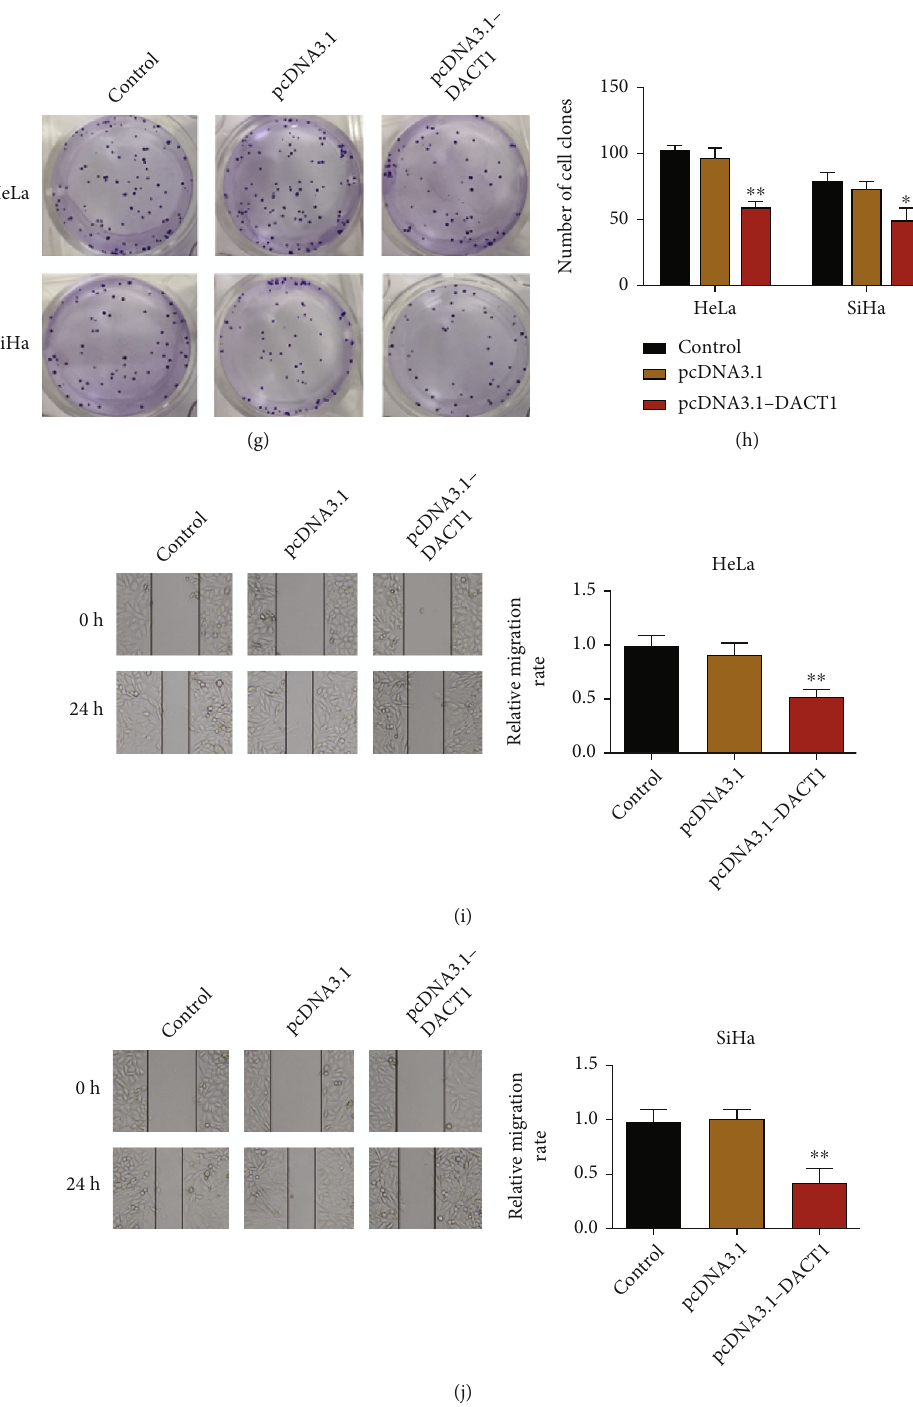
Figure 3: Overexpression of DACT1 leads to suppressed proliferation and migration in both HeLa and SiHa cells. (a) mRNA expression level of DACT1 in HeLa cells after DACT1 overexpression was determined by qRT-PCR; (b) protein expression level of DACT1 in HeLa cells after DACT1 overexpression was determined by western blot; (c) mRNA expression level of DACT1 in SiHa cells after DACT1 overexpression was determined by qRT-PCR; (d) protein expression level of DACT1 in SiHa cells after DACT1 overexpression was determined by western blot; (e) CCK8 assay was applied to assess the e ff ect of DACT1 overexpression on proliferation of HeLa cells; (f) CCK8 assay was applied to assess the e ff ect of DACT1 overexpression on proliferation of SiHa cells; (g, h) cell clone formation assay was used to assess the e ff ect of DACT1 overexpression on cell clones in HeLa cells and SiHa cells; (i, j) wound healing assay analyzed the e ff ect of DACT1 overexpression on cell migration in HeLa and SiHa cells. ∗ p < 0 : 05 , ∗∗ p < 0 : 01 , and ∗∗∗ p < 0 : 001 , compared with the control